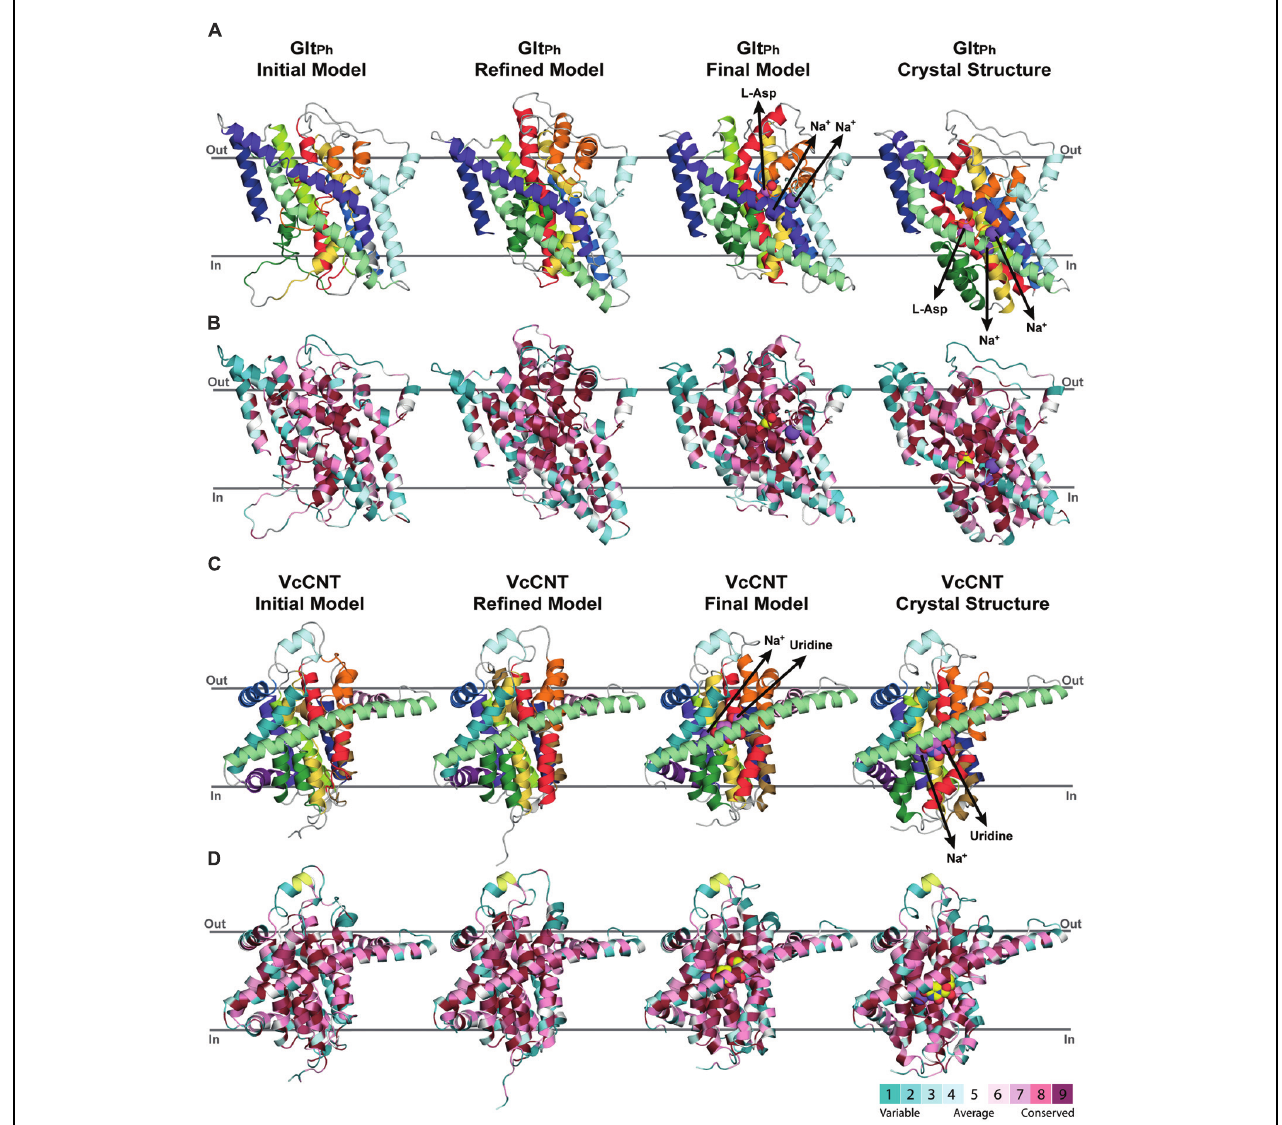
FIGURE 4 | Refinement of repeat-swapped outward-facing models of Glt Ph and VcCNT compared with input inward-facing structures. Models of Glt Ph (A,B) and VcCNT (C,D) built using initial or refined alignments, both before and after applying restraints within the scaffold and transport domains. Models are shown as cartoon helices, colored with separate colors for each helix (see Figure 5 ) in (A,C) , and using ConSurf coloring in (B,D) . Substrates are shown as spheres, with their pathways illustrated using arrows. ConSurf conservation patterns are mapped to the helices using colors from cyan (most variant residues) to dark pink (most conserved residues); yellow indicates positions with insufficient sequence information to allow a conservation assignment. As seen for the X-ray structures ( right ), conserved residues cluster on the inside of the protein, and at oligomerization interfaces, while variant residues are found primarily on the surface. This observation, and the patterns seen in the template structure were used to guide the refinement of the alignments. The position of the proteins in the membrane was determined with the OPM